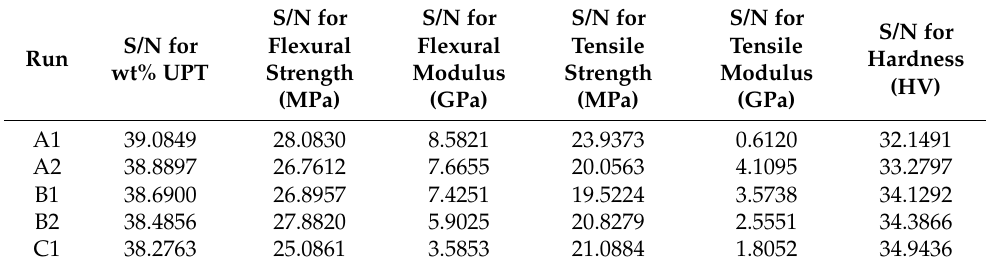
Table 2. Experimental result of the S/N ratio values for mono-reinforced composites.